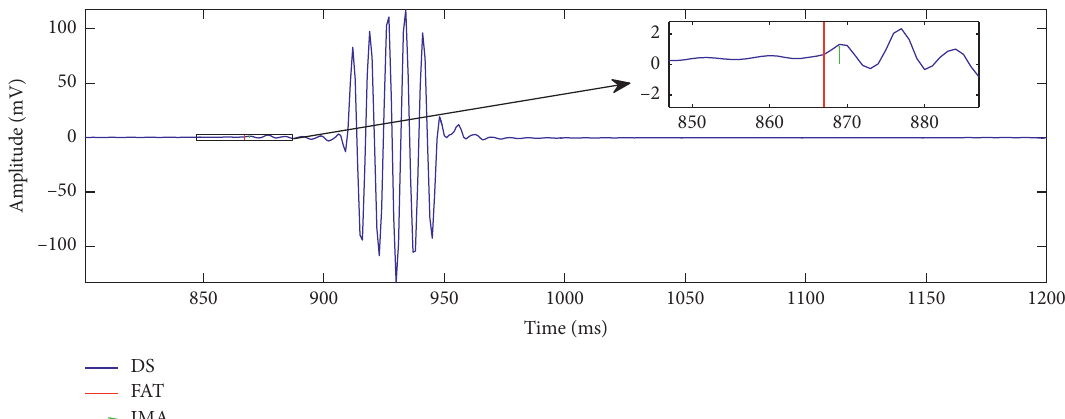
Figure 10: Typical preprocess signal of CSHF (blue line) and associated parameters for MTs calculation (first arrival time in red line, initial motion amplitude in green line).